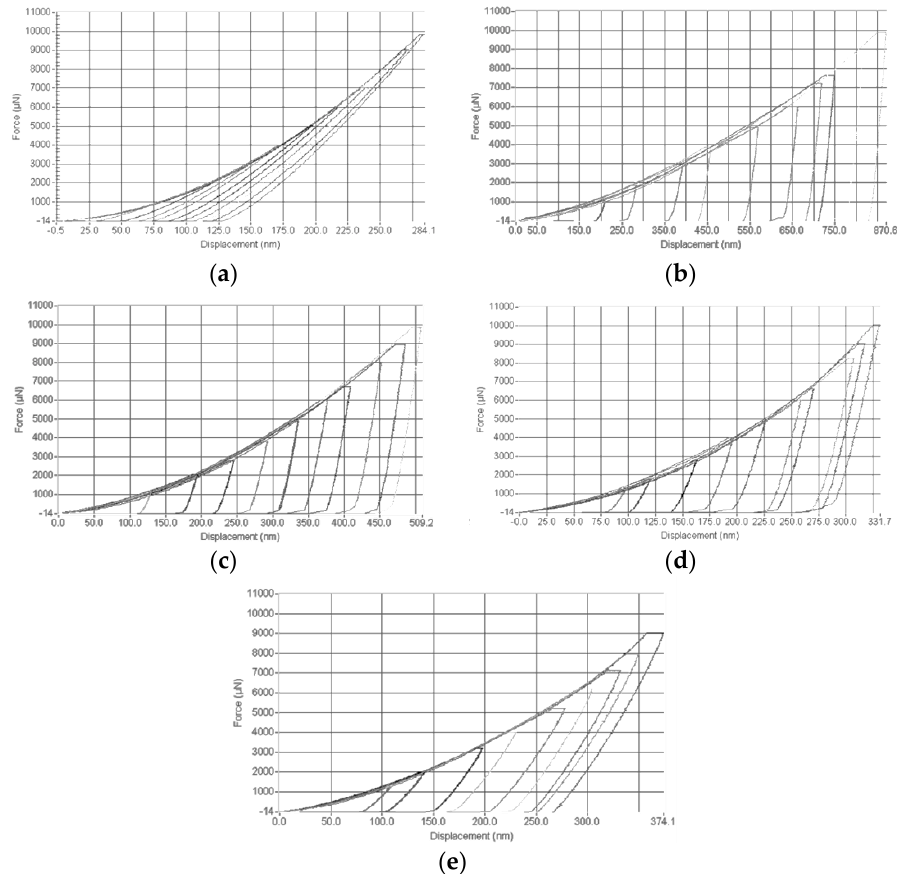
Figure 4. Force ‐ displacement curves, where force is the applied load obtained for fused quartz ( a ), commercially pure aluminum ( b ), DHP copper ( c ), annealed 100 Cr6 steel ( d ), and grey cast iron ( e ). Each load ‐ displacement curve is representative of an 8 × 8 series of individual tests.